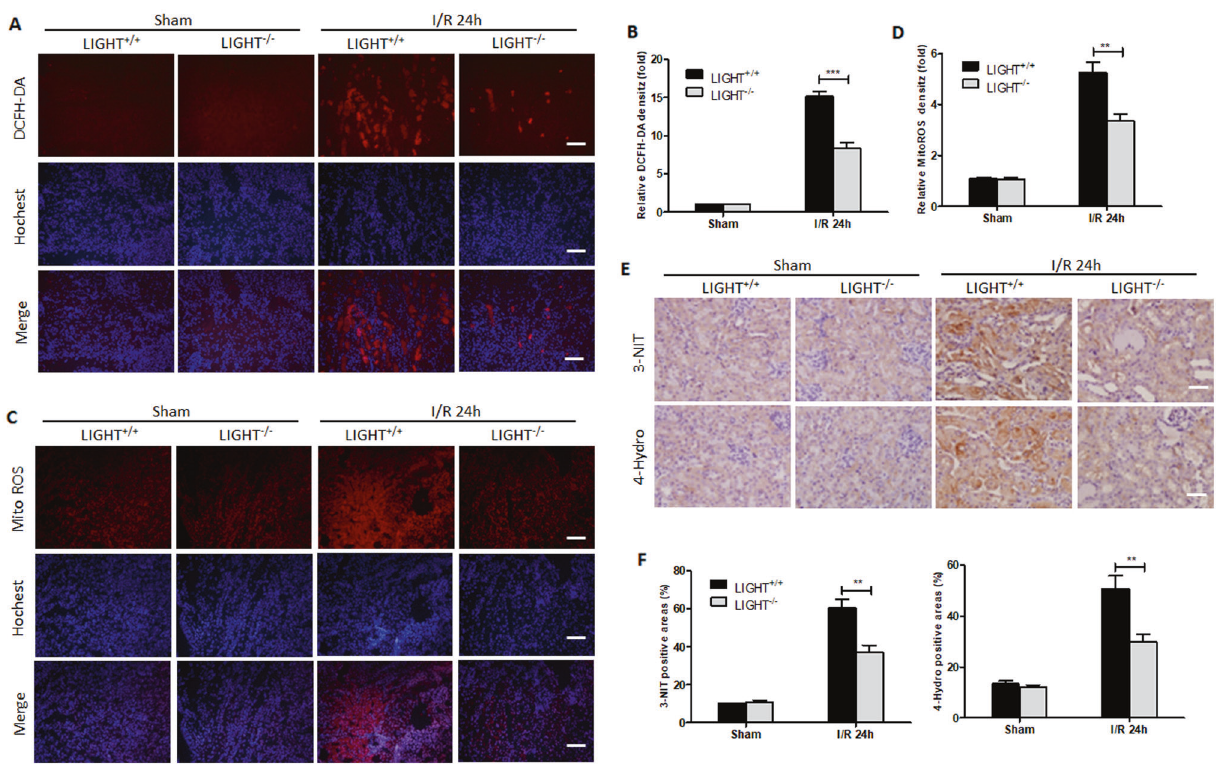
Fig. 3 LIGHT de fi ciency attenuates ischemia-reperfusion-induced oxidative stress. Wild-type (LIGHT + / + ) and LIGHT (LIGHT − / − ) mice received renal ischemia followed by reperfusion for 24 h. A IF staining for DCFH-DA in frozen kidney sections. Scale bar, 50 μ m B Quanti fi cation of DCFH-DA-positive areas per HPF. C IF staining for mitochondrial ROS. Scale bar, 50 μ m. D Quanti fi cation of mtROS-positive areas per HPF. E 3-NIT and 4-hydro expression were tested by IHC. Scale bar, 50 μ m. F Both 3-NIT and 4-hydro-positive areas were quanti fi ed. Values are presented as mean ± SEM. ( n = 6 – 8 for each group). Differences between the two groups were assessed with Student ’ s t test. ** p < 0.01; *** p < 0.001 vs. LIGHT + / + mice with